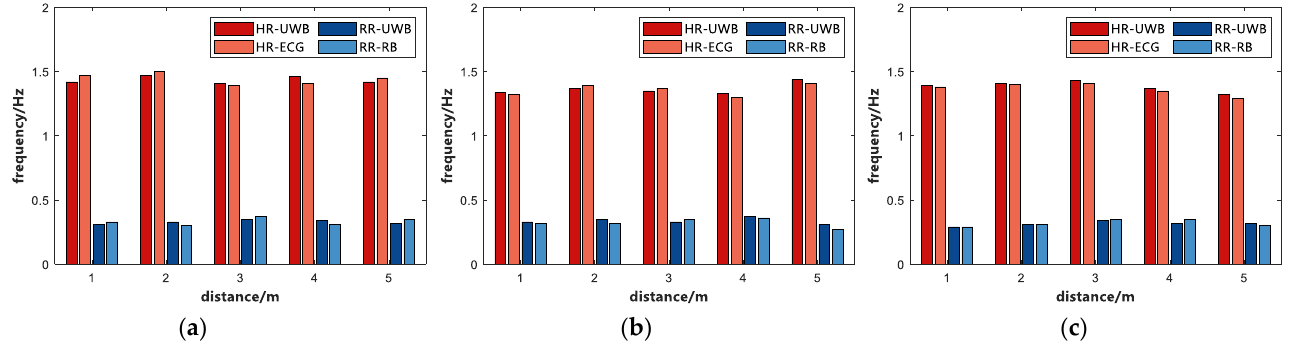
Figure 4. The estimated vital signs of subject A in three different environments and at different distances. ( a ) Complex indoor environment. ( b ) Open indoor environment. ( c ) Open outdoor envi- ronment. Table 2. Vital signs errors and SNR at different distances parameter setting of IR-UWB radar. 1